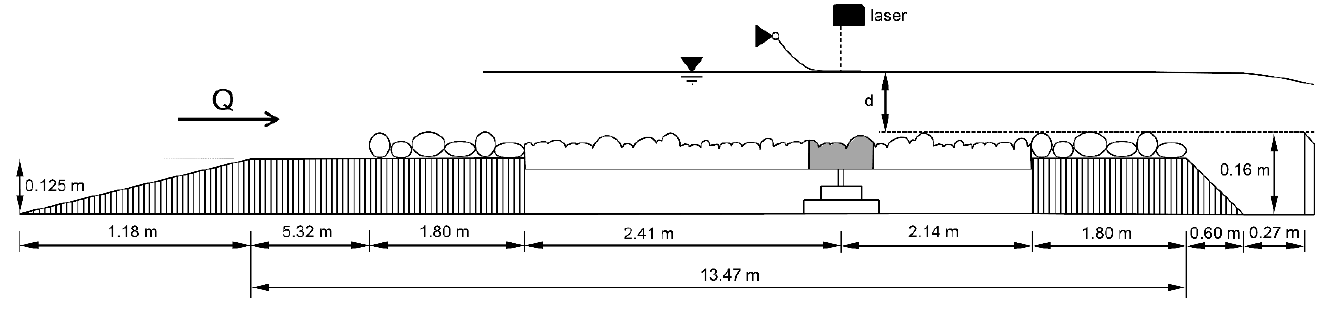
Figure 2. Experiment setup. Longitudinal section. Not to